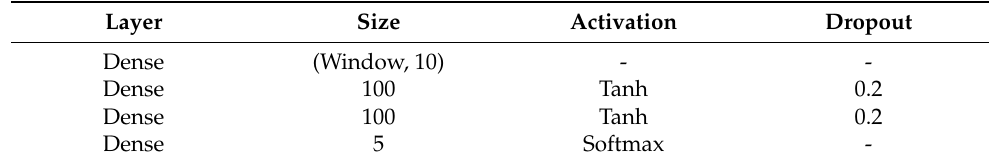
Table 7. Employed LSTM network